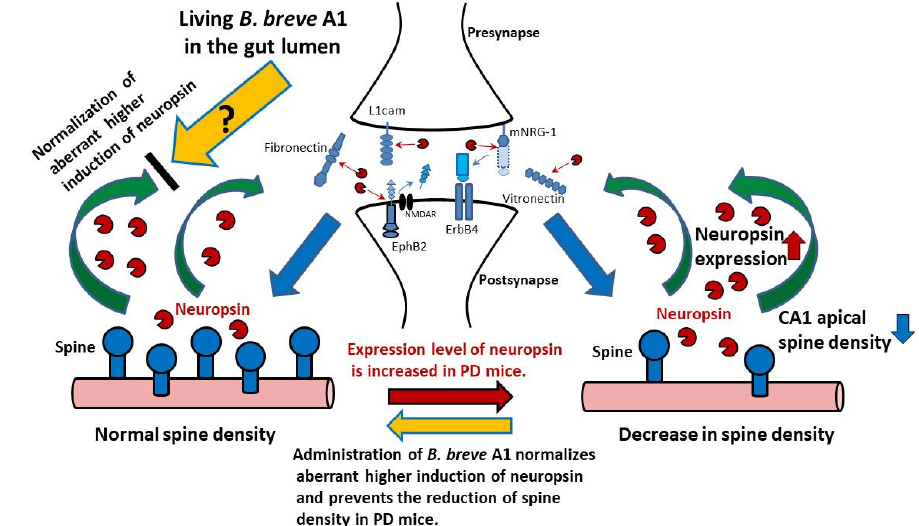
Figure 9. Living B. breve A1 in the gut lumen leads to the restoration of PD-induced aberrant higher induction of neuropsin, the mechanism of which is caused by a still unknown signal via the gut–brain axis. Neuropsin-mediated signaling plays an important role in synaptic plasticity; physiologically activated neuropsin cleaves extracellular proteins in the synaptic cleft such as fibronectin, vitronectin, L1cam, EphB2 (the cleavage of EphB2 reduces EphB2-NMDA binding), and mNRG-1(the released moiety cleaved from mNRG-1 binds ErbB4 and triggers its phosphorylation), and modifies pre- and postsynaptic interactions and synaptic signal transmission [22,34]. However, an aberrant higher induction of neuropsin observed in PD mice causes abnormal changes in hippocampal synaptic plasticity and function. Oral administration of B. breve A1 restored the facilitation of contextual fear extinction and the decreased hippocampal dendritic spine density in PD mice via normalization of an aberrant higher induction of neuropsin. Abbreviations: EphB2, EPH receptor B2; ErbB4, NRG-1 receptor p185; L1cam, L1 cell adhesion molecule; mNRG-1, mature neuregulin-1; NMDAR, N -methyl- D -aspartic acid receptor.